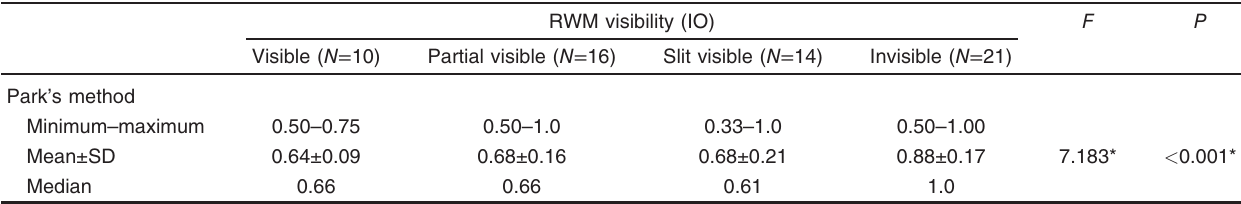
Table 2 Relation between round window membrane intraoperative visibility and modified Park ’ s method ( N = 61)